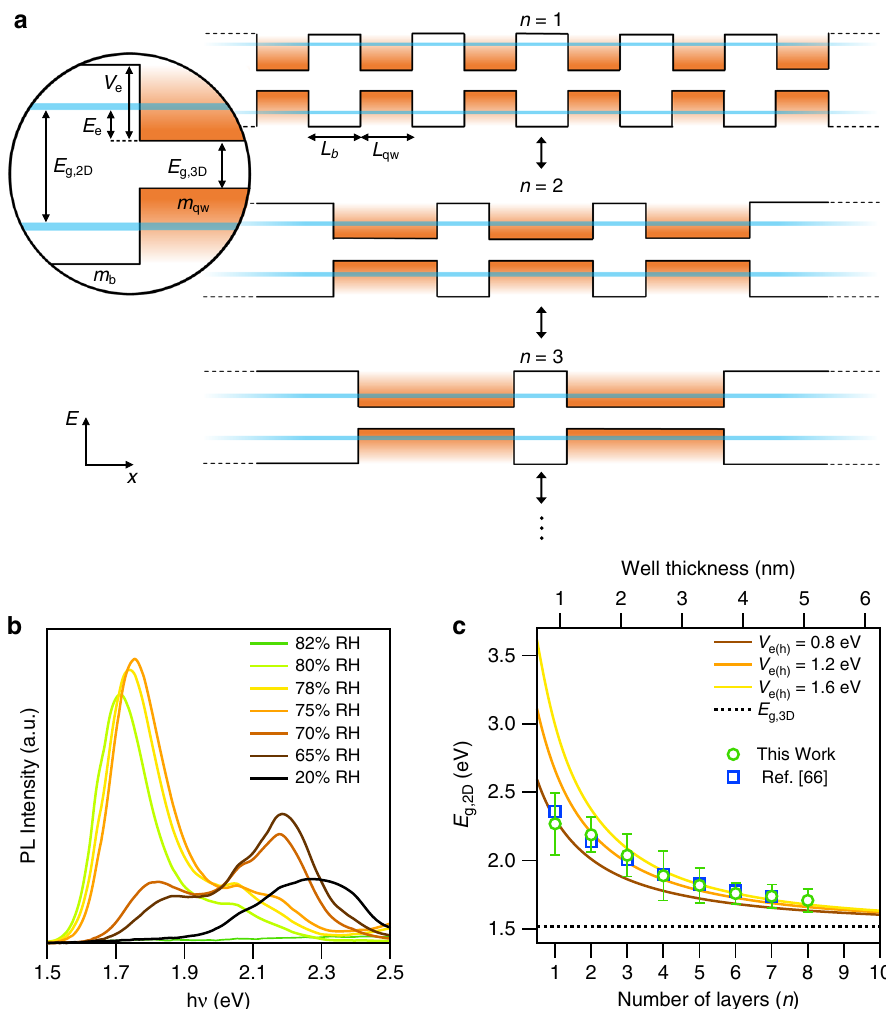
Fig. 6 Superlattice description of FA n + 1 Pb n I 3n + 1 optical properties. a Diagram of the Kronig – Penney-like model used to describe FA n + 1 Pb n I 3n + 1 optical properties. b Photoluminescence (PL) of hygrochromic FA n + 1 Pb n I 3n + 1 fi lms collected at various relative humidity (RH). Each spectrum exhibits multiple peaks due to a mixture of ‘ n ’ layers. c A plot of the peak PL position and models used to describe our PL data. Marker position corresponds to the peak of the PL spectra in ( b ), and the error bars are the full-width at half maximum of the peak. Model parameters are described in the